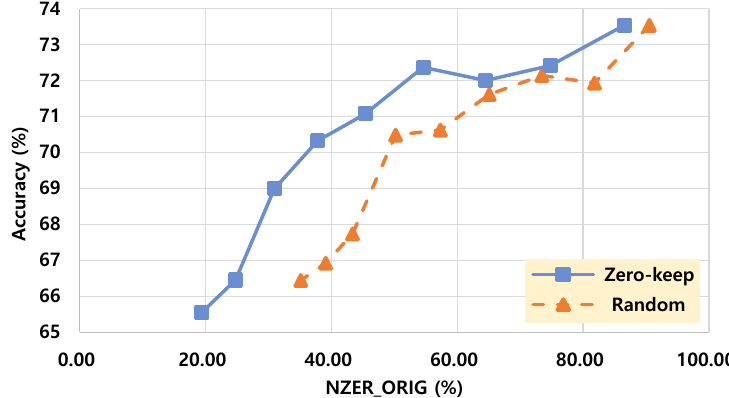
Figure 7. Non zero element rate versus accuracy trade-off comparison on